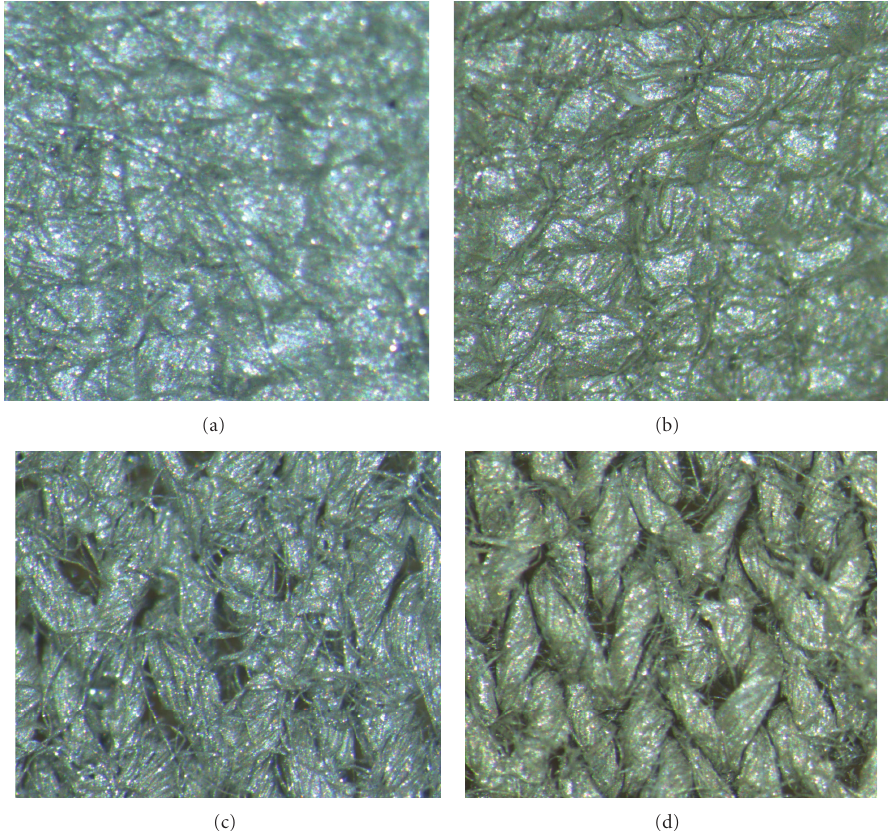
Figure 12: Antenna surface on Fabric (A): (a) before washing and (b) after ten washes. Antenna surface on Fabric (B): (c) before washing and (d) after ten washes. Magnification is ×